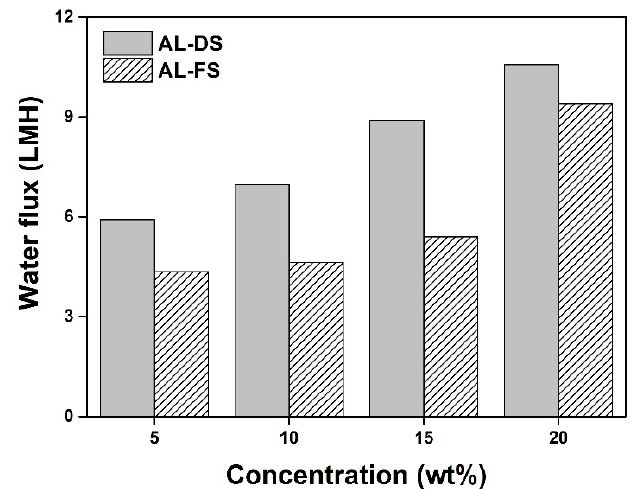
Figure 8. Water flux of octane-1,8-diylbis(tributylphosphonium) 2,4-dimethylbenzenesulfonate ([(P 4444 ) 2 ][MBS]) according to the concentration at room temperature during forward osmosis process in AL-DS mode and AL-FS mode.